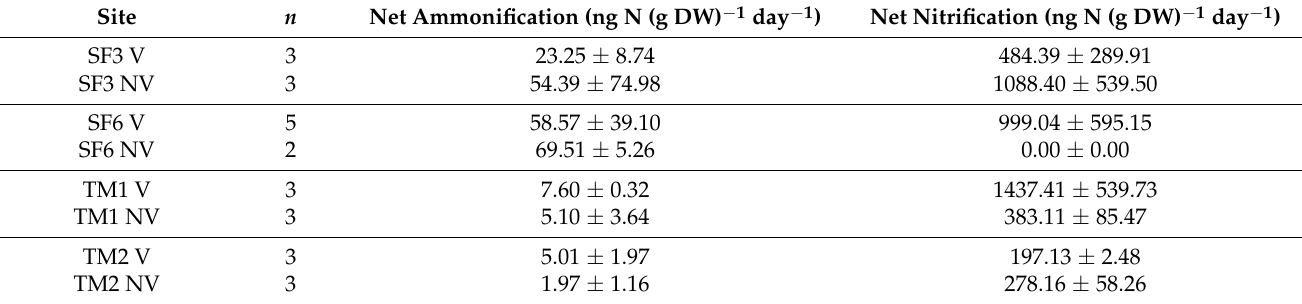
Table 3. Net N transformation rates of incubated soil slurries (4 °C for 40 days) from revegetated (V) and non-vegetated (NV) slump floor (SF) and thaw mounds (TM) soils under oxygen supply and pH 7.2 ( n = number of replicates).